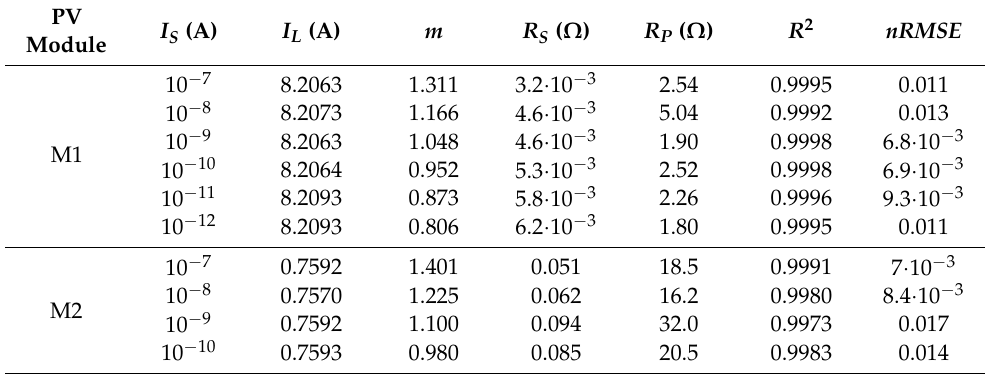
Table 2. The one-diode model parameters and the replication performance of the experimental I-V characteristics. I S was set a priori whereas ( I L , m , R S , R P ) were estimated with